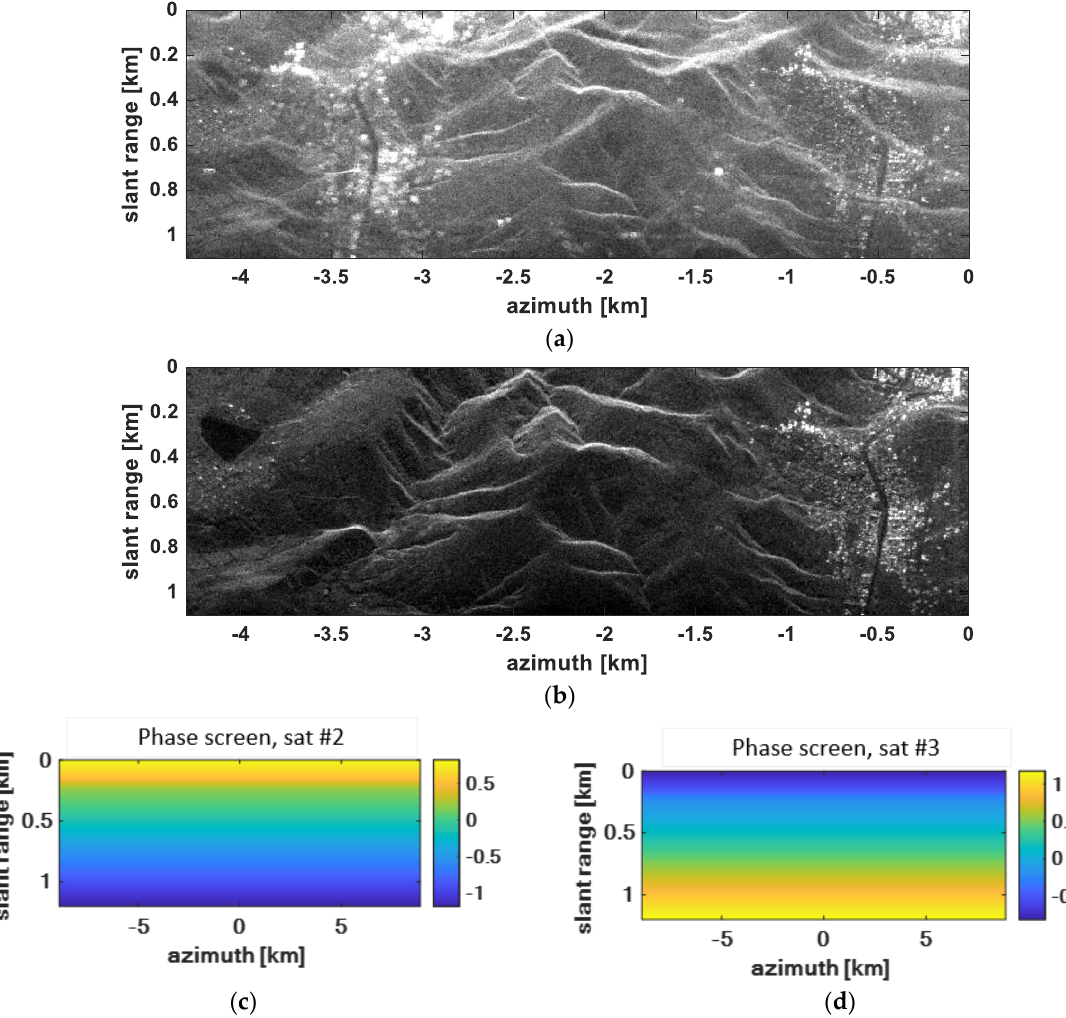
Figure 14. ( a ) Simulation of the SIMO image generated by assuming an incorrect knowledge of the 381 across-track baselines of the three sensors. The represented amplitude is remarkably affected by 382 ambiguities. The mitigation of ambiguities has been achieved according to the proposed approach 383 by separately focusing the three images, estimating the phase screens ( c , d ), and compensating from 384 images #2 and #3 before combining them into the final one, shown in ( b ).